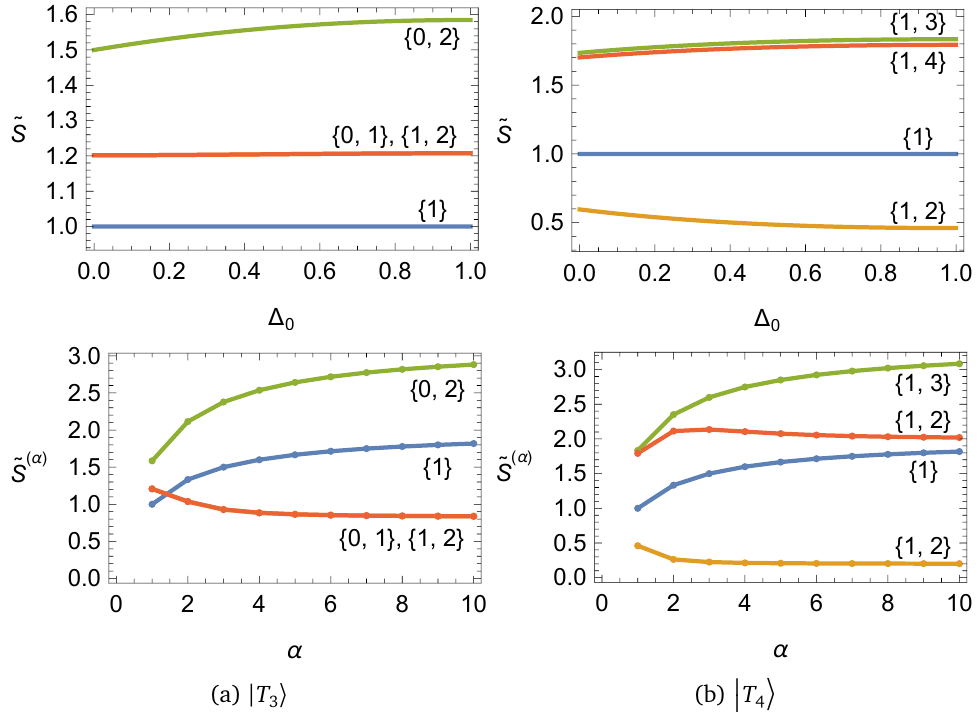
( | T 〉 ) / ln2 j 1 ,..., j k } n